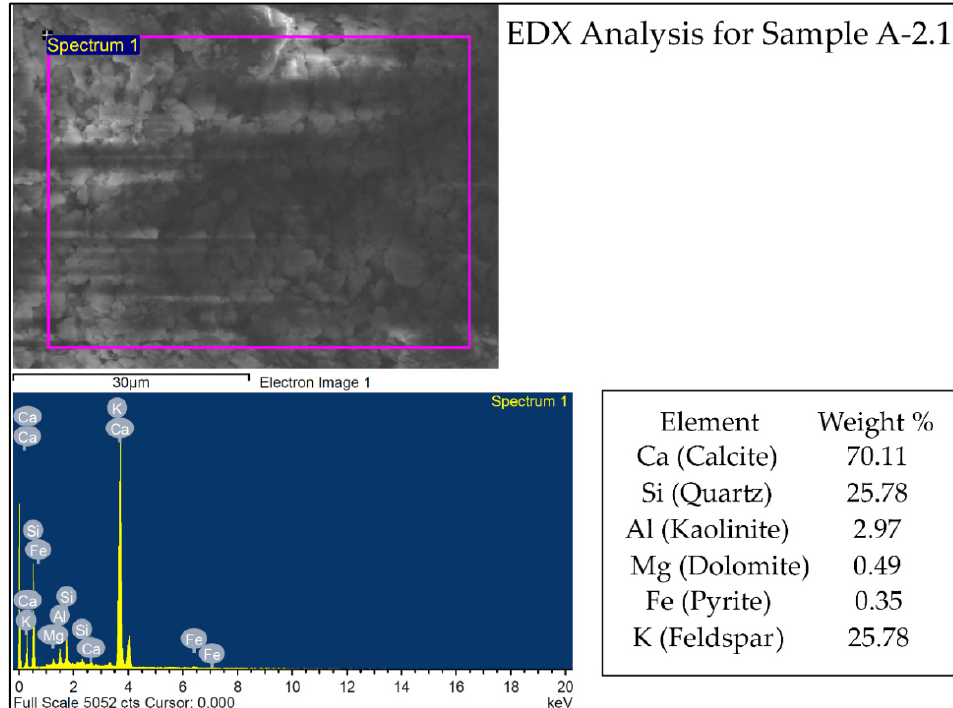
Fluids 2021 , 6 , x FOR PEER REVIEW Figure 4. EDX analysis of sample A-2.1. Figure 4. EDX analysis of sample A-2.1.